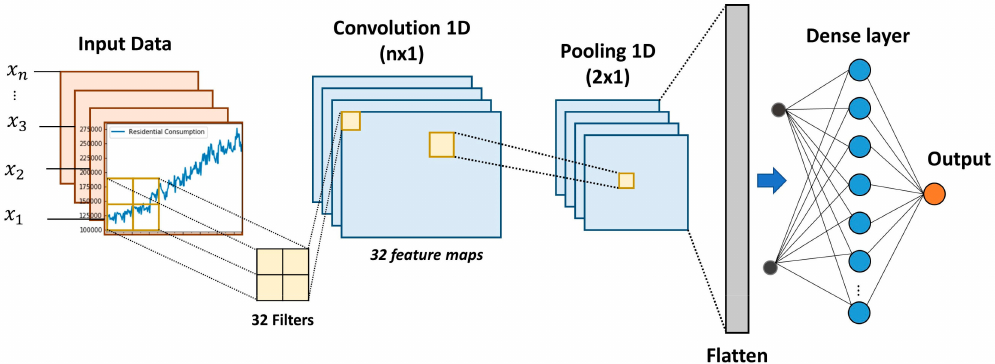
Figure 9. Multivariate CNN